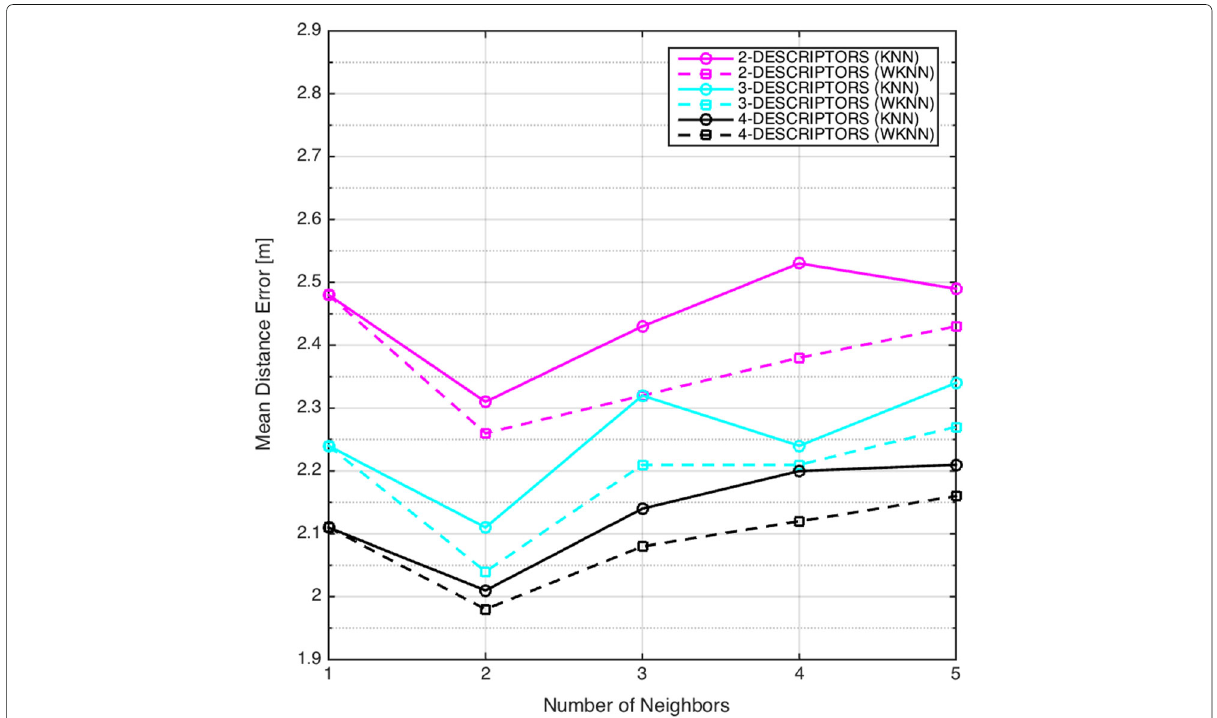
Fig. 12 Effect of classifier selection on localization performance in a wideband scenario. Mean Distance Error vs K (number of neighbors) for RSRP/CSI descriptors using KNN and WKNN classifiers